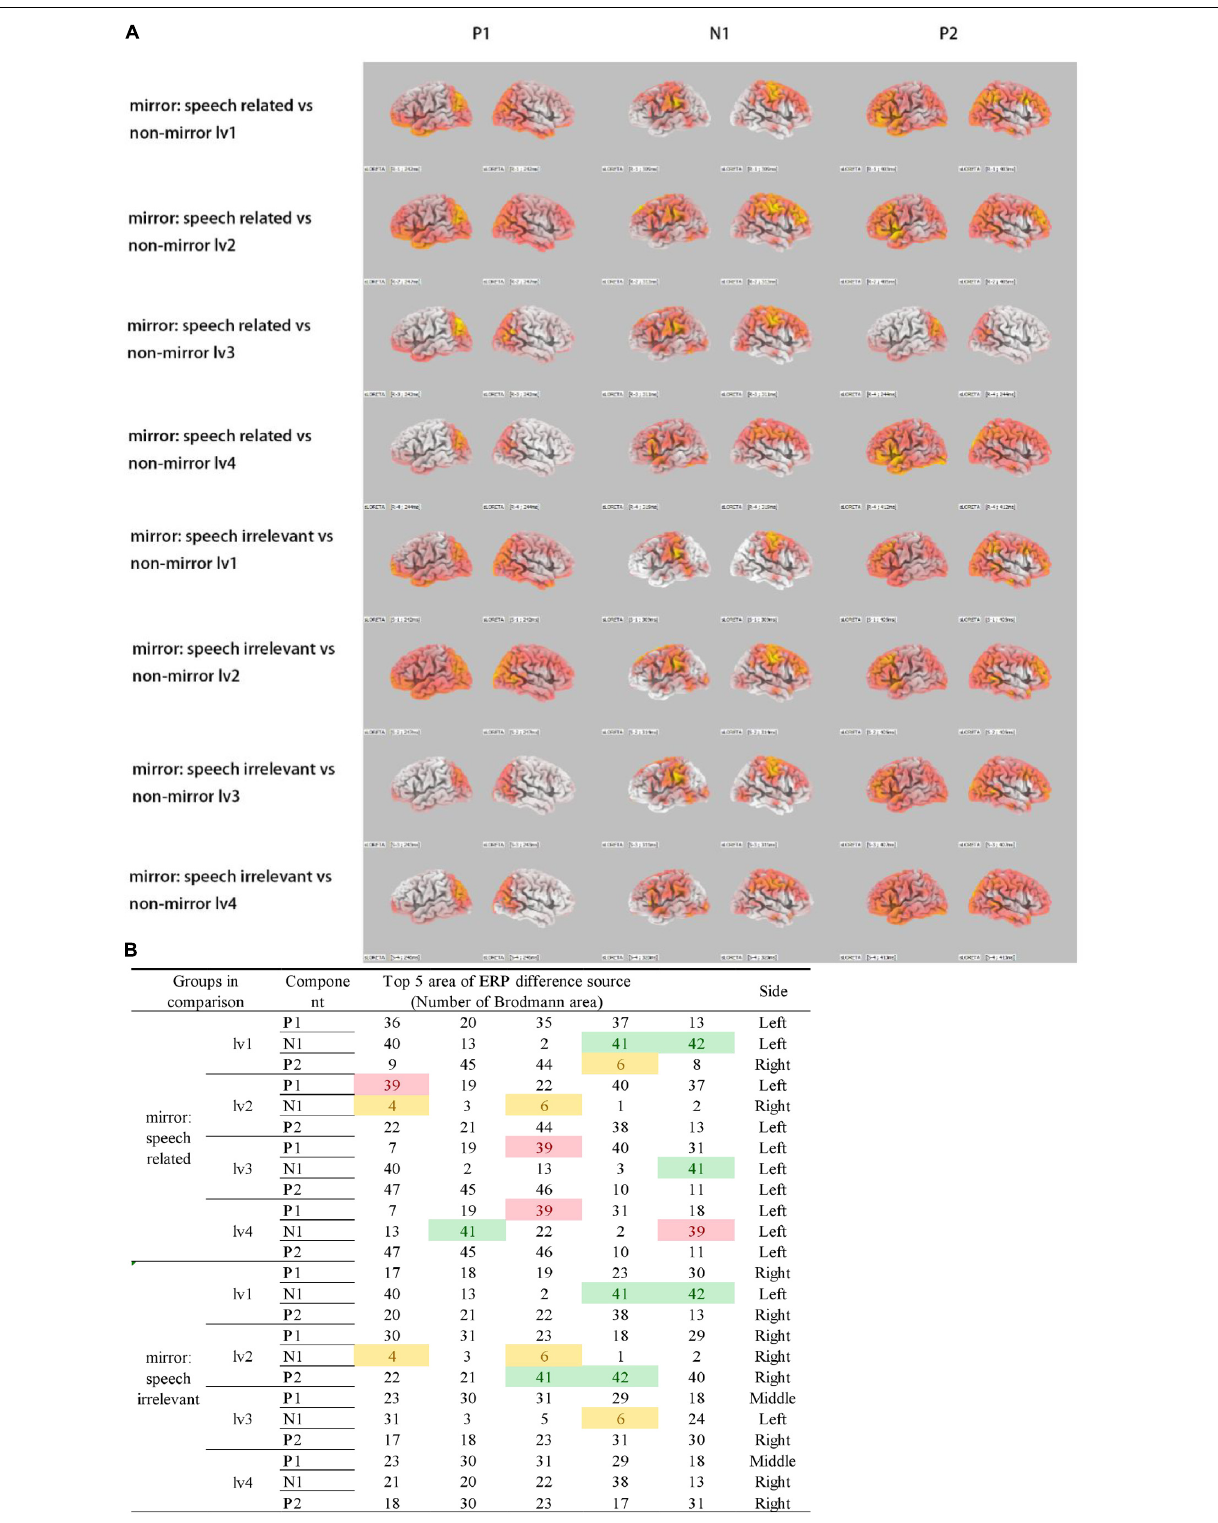
Frontiers in Neuroscience |